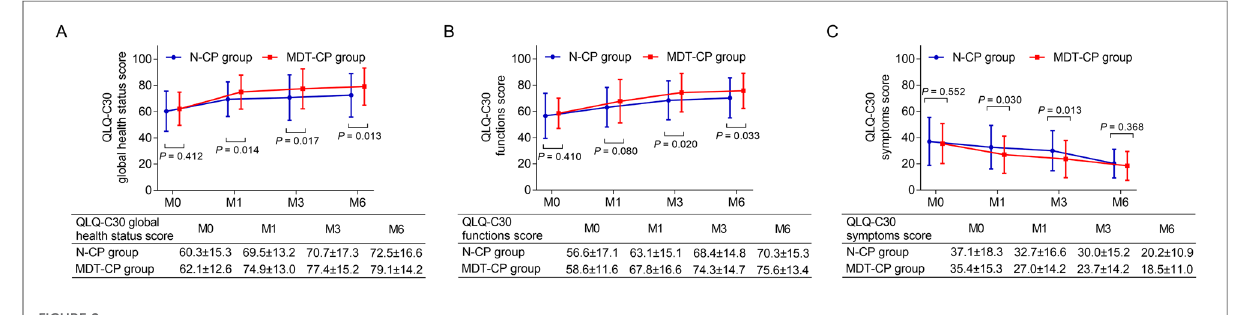
FIGURE 2 Qol was elevated in MDT-CP group compared to N-CP group. QLQ-C30 global health status score ( A ) and QLQ-C30 functional score ( B ) were elevated, whereas QLQ-C30 symptom score ( C ) was reduced in MDT-CP group compared with N-CP